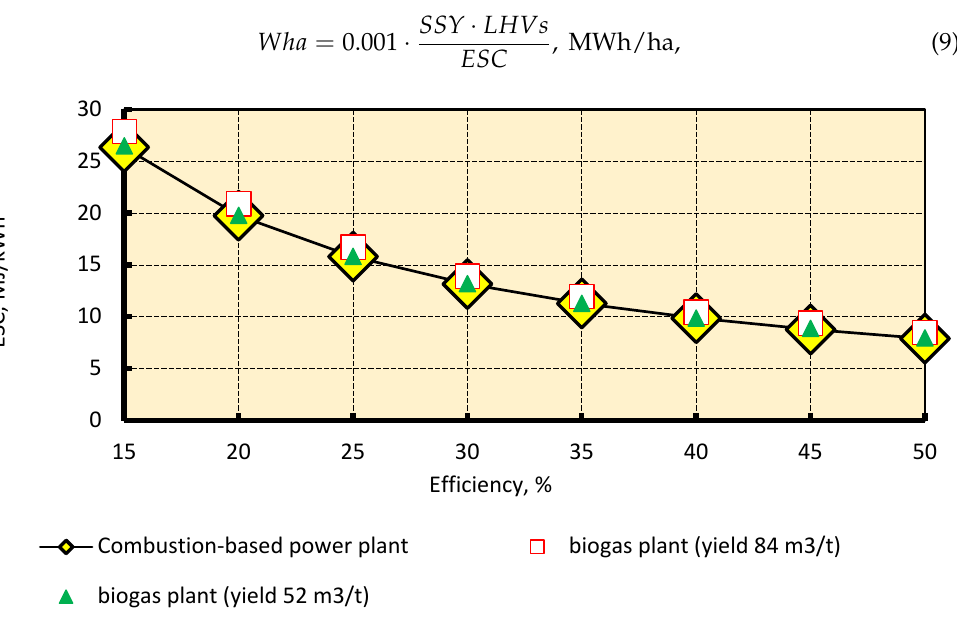
Figure 5. Energy-specific costs.